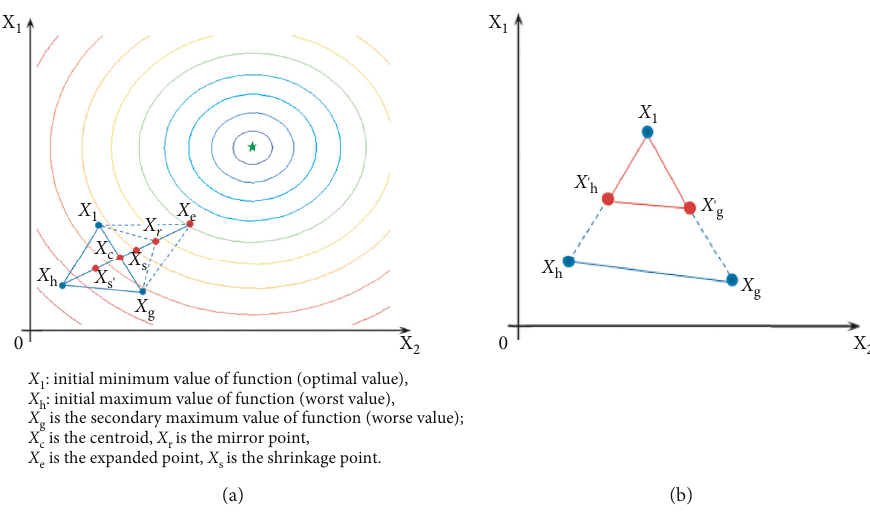
Figure 2: (a) Schematic of the simplex vertex; (b) the schematic of the edge contraction.